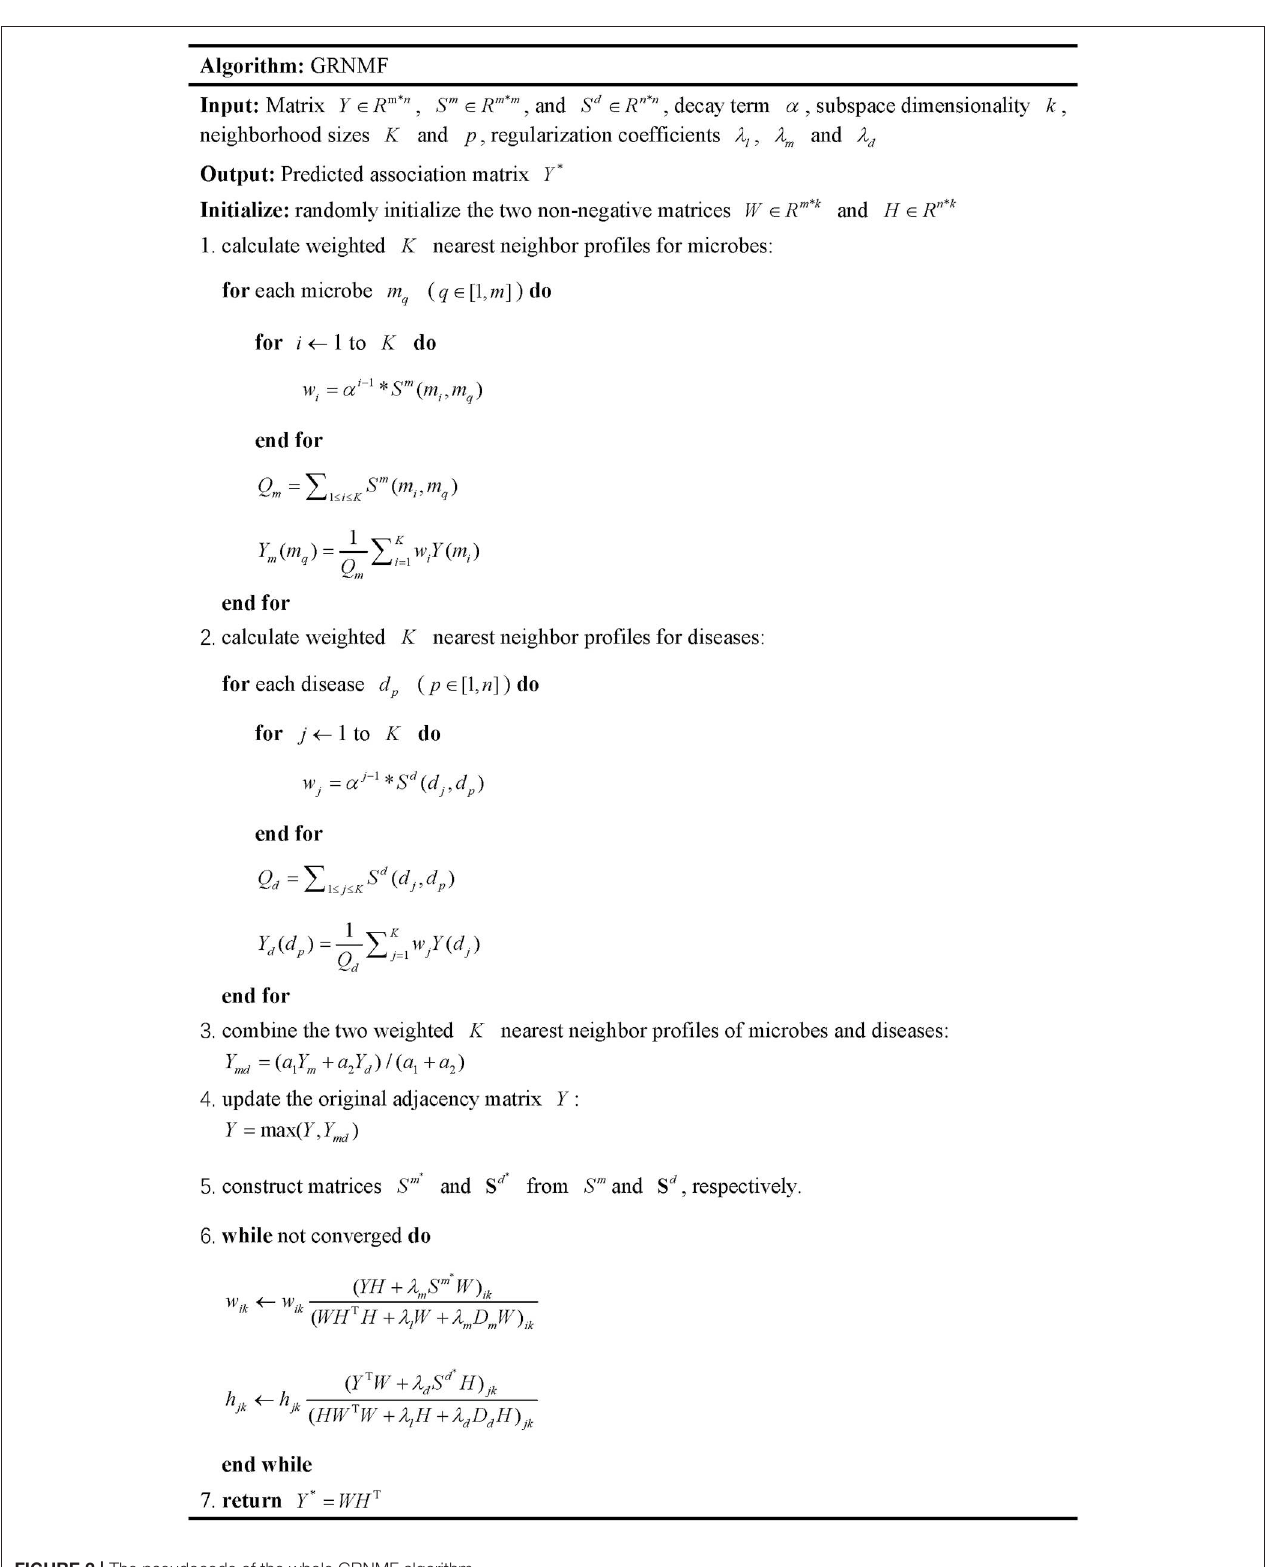
FIGURE 2 | The pseudocode of the whole GRNMF algorithm.